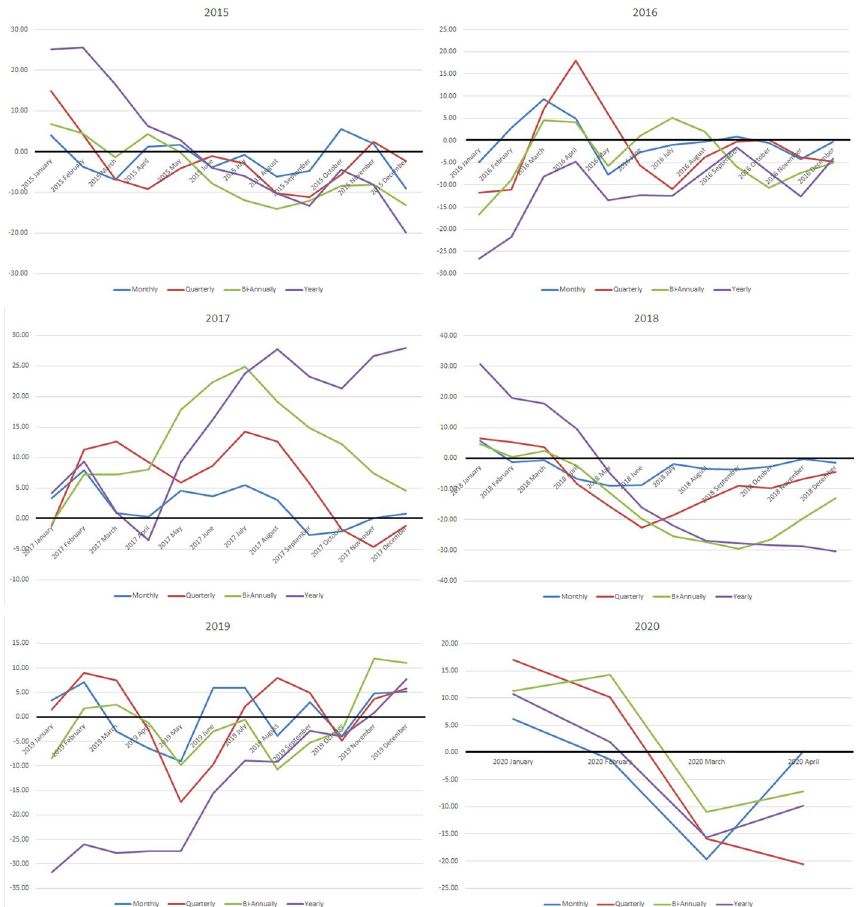
Fig. 7 The real rate of return in BIST100 during January/2015-April/2020. Source : Turkish Statistical Institute ( TurkStat), 2021. (https:// turks tatweb. tuik. gov. tr/ PreTa blo. do? alt_ id